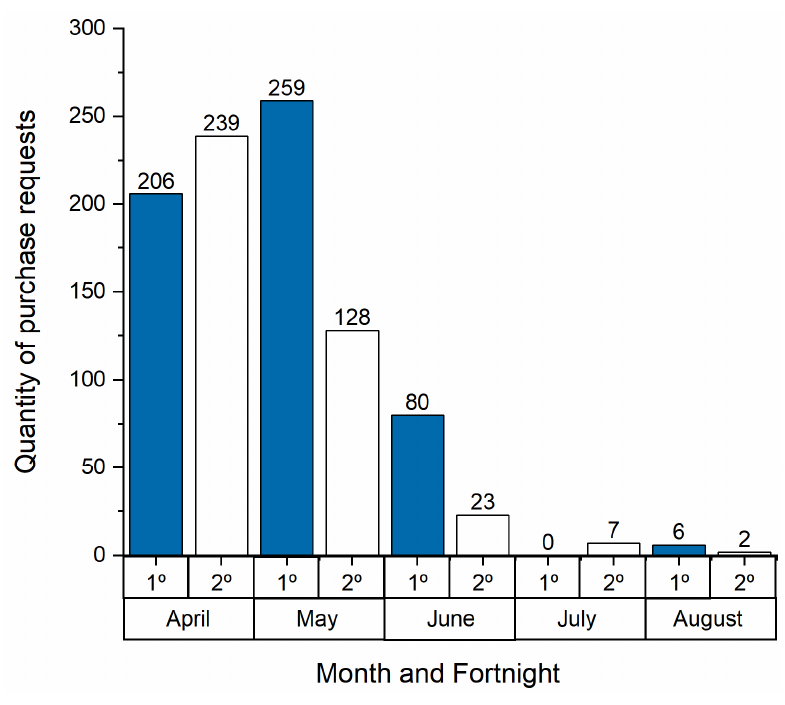
Figure 11. Number of part purchase orders per fortnight between April and August at the Refer- ence Unit.